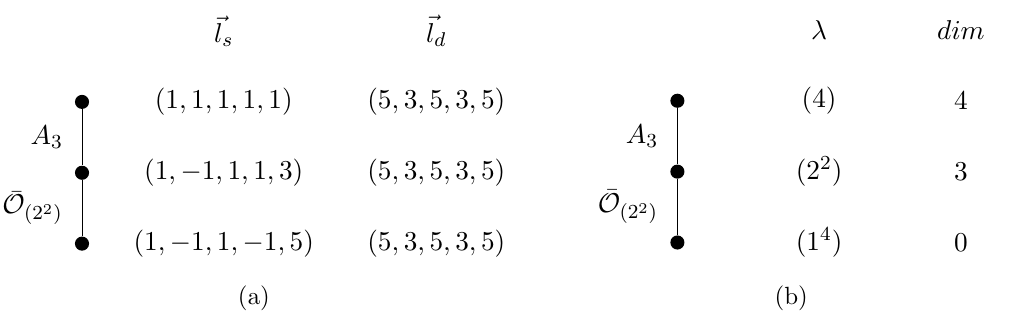
Figure 49. Hasse diagram for the models whose Higgs branch is the closure of a special nilpotent orbit of sp (2) under the adjoint action of the group Sp(2). (a) represents the brane con(cid:12)gurations, where the linking numbers ~l s and ~l d are provided for each orbit and the rightmost orientifold plane is always of type g O 3 + . (b) depicts the information of the orbits. (cid:21) is the partition obtained from the interval numbers ~ k s as discussed above. dim is the number of physical D3-branes that generate the Higgs branch in each